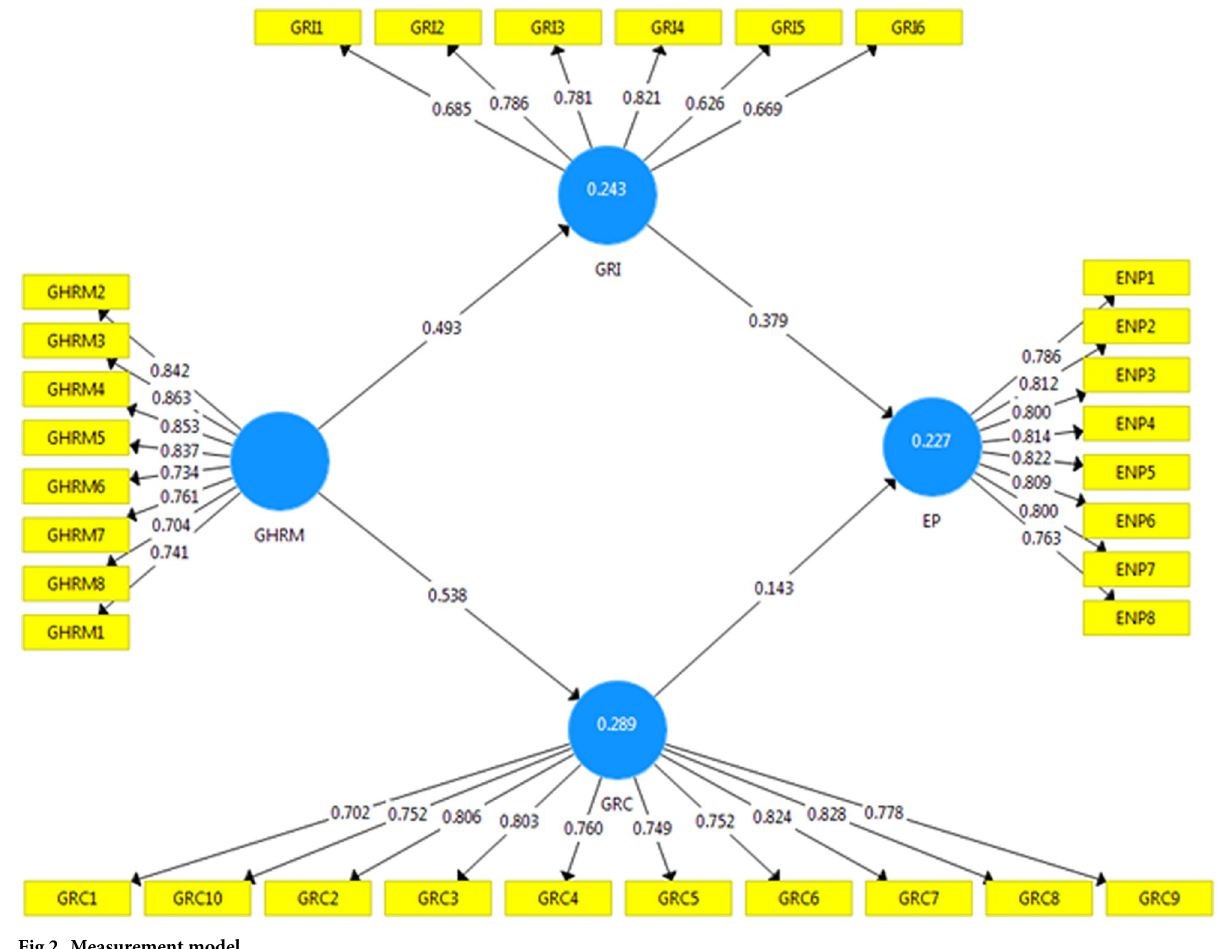
Fig 2. Measurement